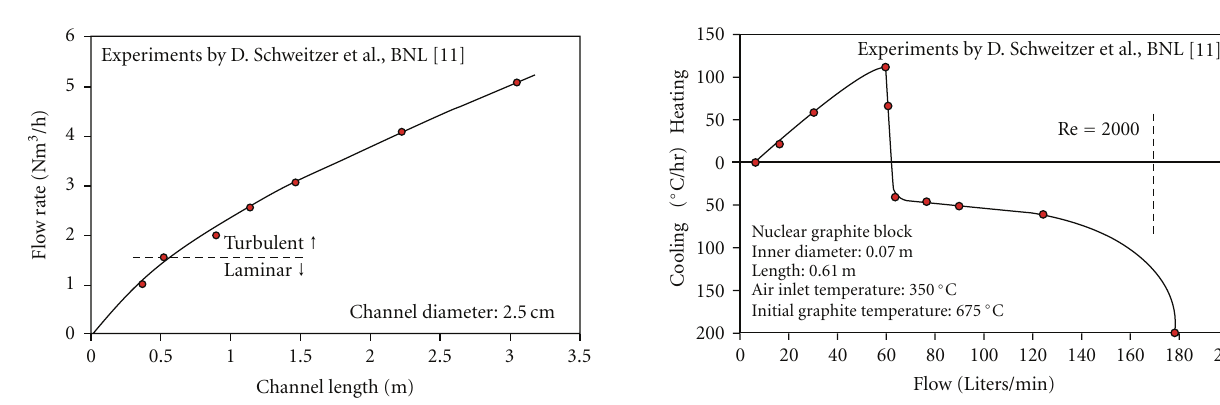
Figure 5: Coolable channel length depending on flow (705 ◦ C). Figure 6: Heating/cooling rates versus flow